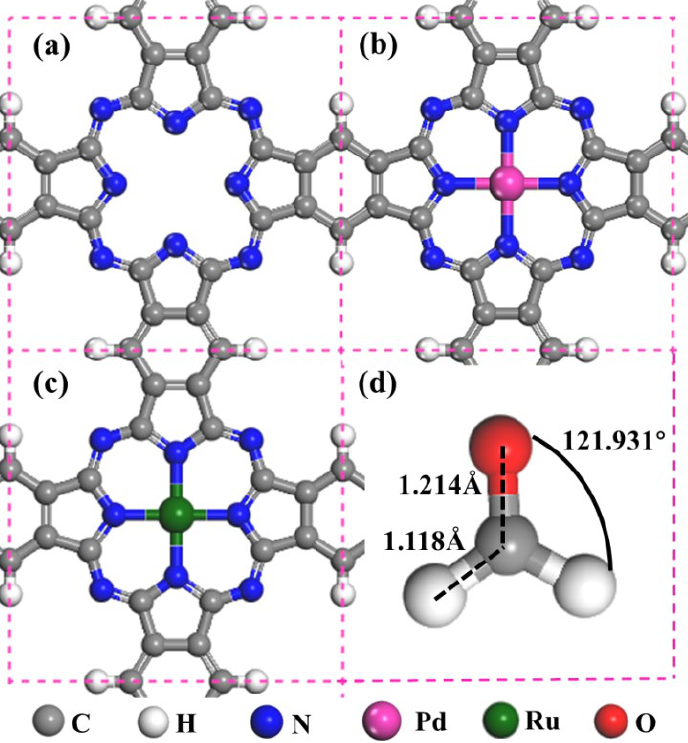
Figure 1. Optimized structure model: ( a ) Pc monolayer, ( b ) PdPc monolayer, ( c ) RuPc monolayer, and ( d ) CH 2 O gas molecule.